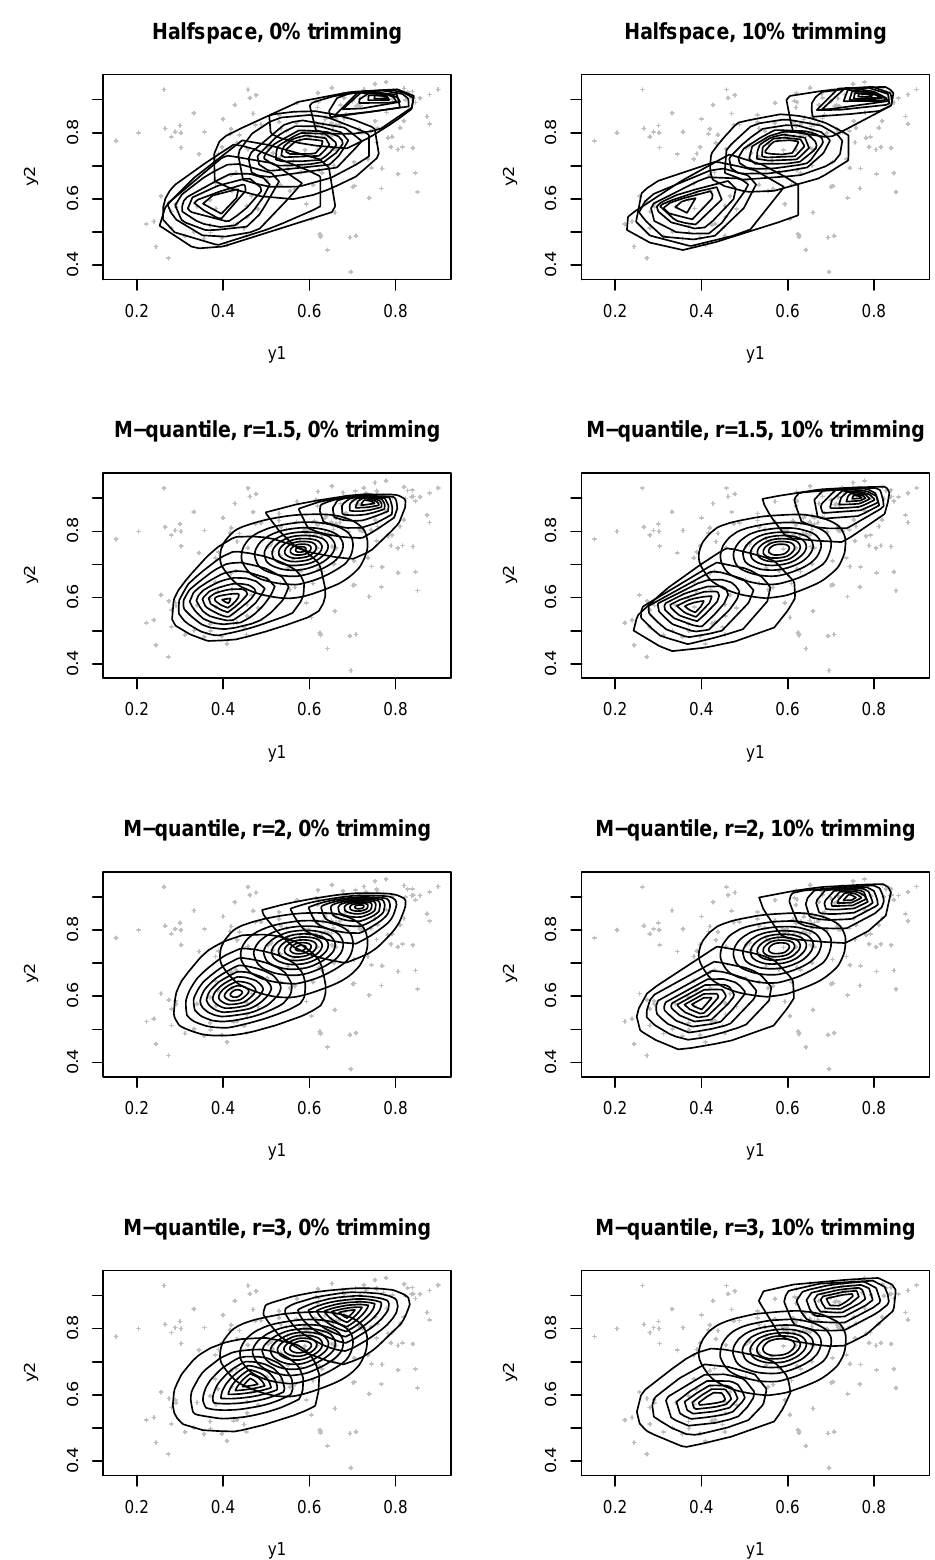
Figure 3. Halfspace and M -quantile conditional regions for various power loss